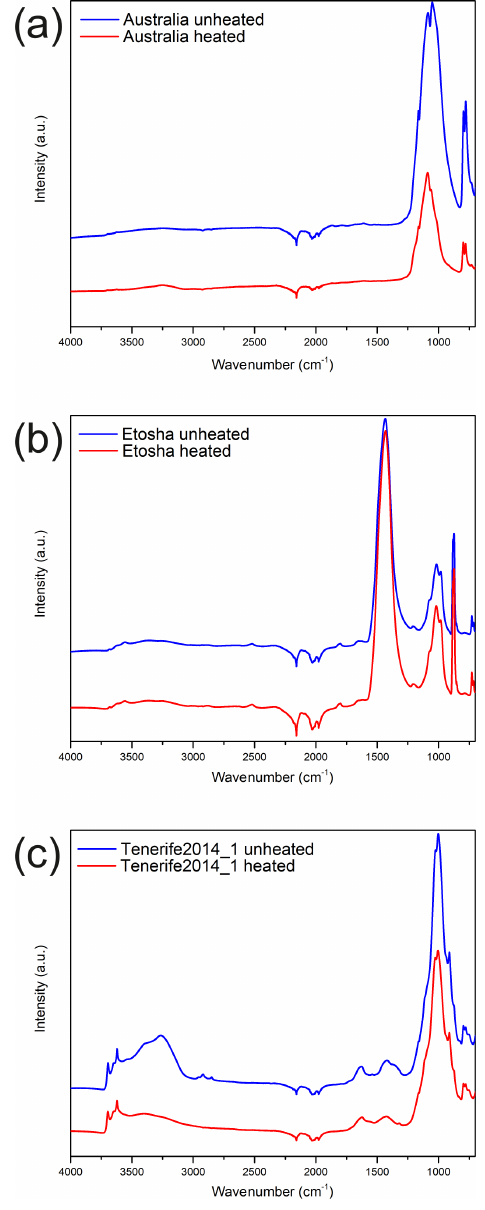
Figure 5. Attenuated total reflectance infrared (ATR-IR) spectra for the (a) Australia, (b) Etosha, and (c) Tenerife2014_1 samples before (blue) and after heating